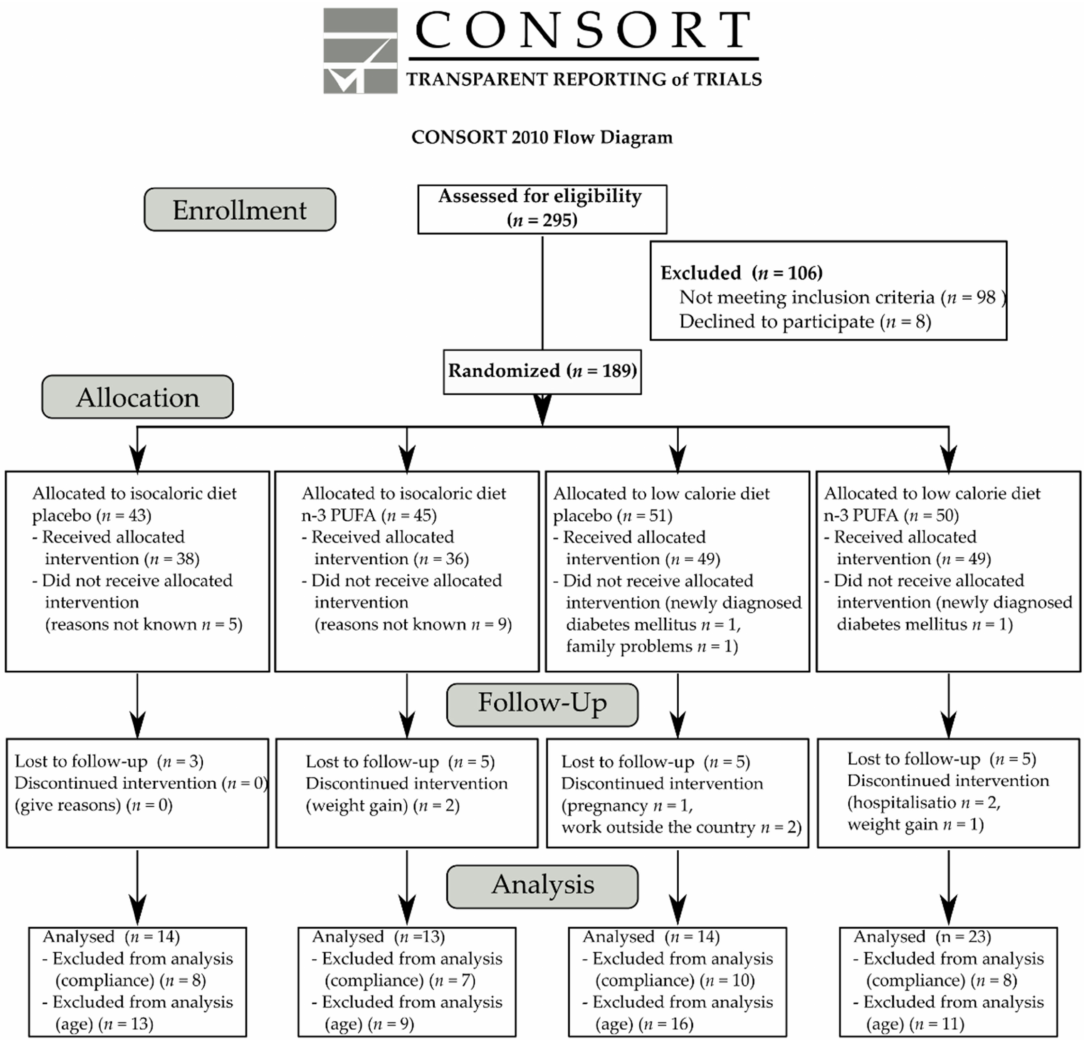
Figure 1. CONSORT flow